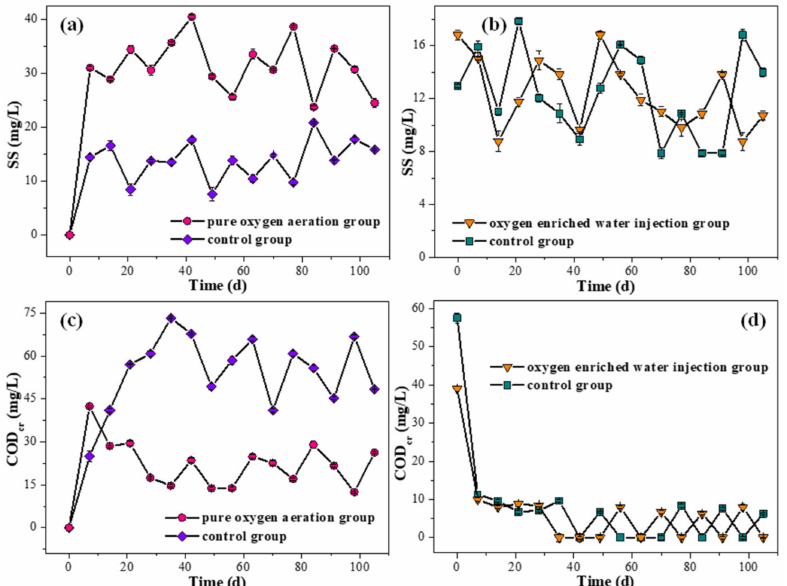
Figure 3. The e ff ects of ( a ) pure oxygen aeration treatment and ( b ) oxygen enriched water injection treatment on the suspended solids (SS) concentration in the overlying water; the e ff ects of ( c ) pure oxygen aeration treatment and ( d ) oxygen enriched water injection treatment on chemical oxygen demand (COD Cr ) concentration in the overlying